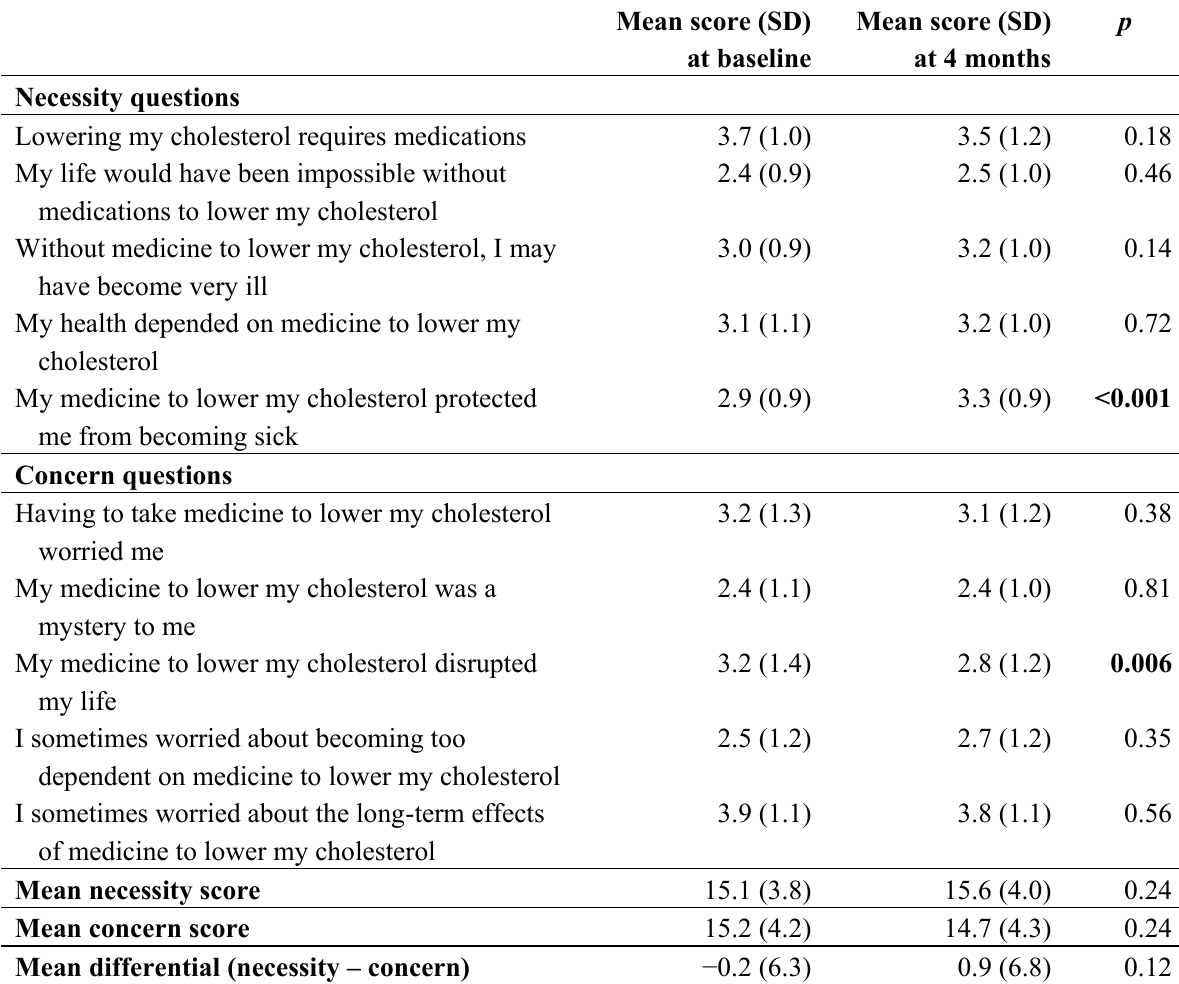
Table 2. Changes in the Beliefs about Medications Questionnaire after receiving